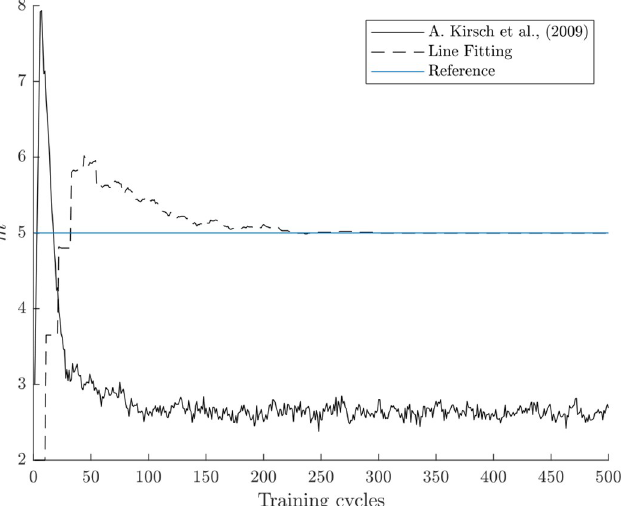
Fig 10. Dimensionality adjustment process on the CareerCon19 [51] data set with different approaches and θ = 0.99. The horizontal line is a reference dimensionality calculated with an offline PCA. The solid line is the dimensionality adjustment process with the novel approach presented in this work, while the dashed line represents [7]. Each data point in the other two line is the mean of 100 repetitions.